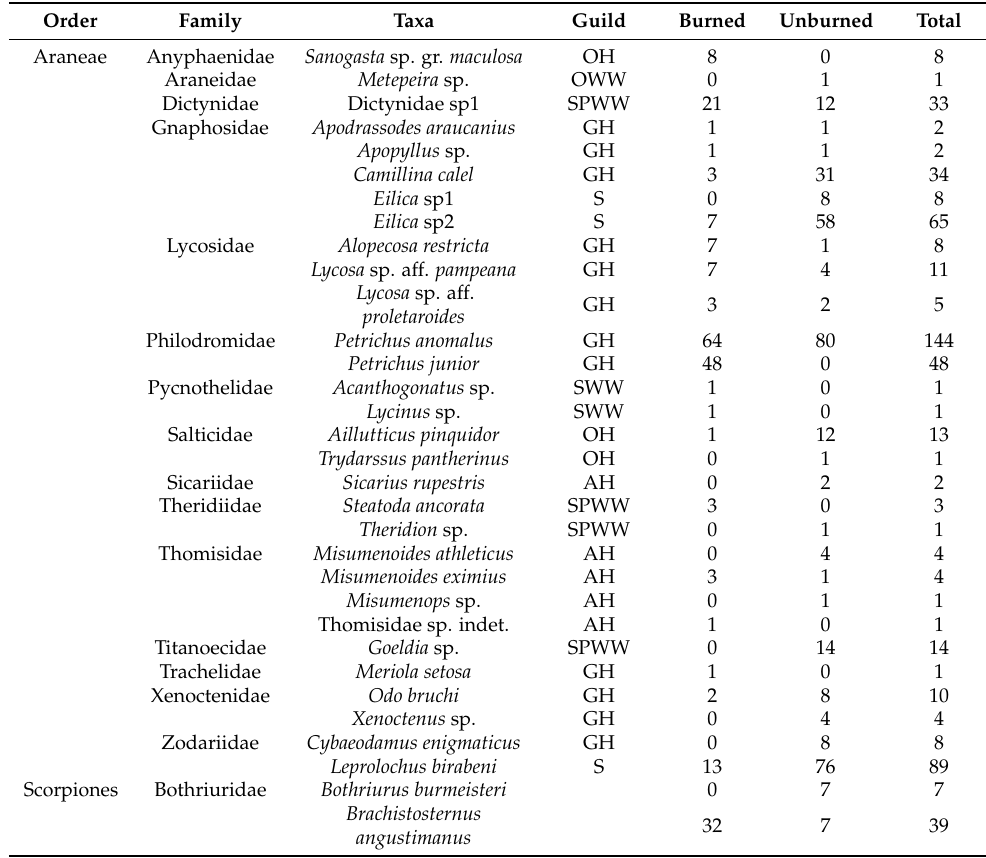
Table 1. Abundance of arachnid species/morphospecies in burned and unburned areas. The total abundance of each taxon and the assignment of spiders to each guild are also indicated. Guild abbreviations: AH = ambush hunters, GH = ground hunters, OWW = orb web weavers, OH = other hunters, SWW = sensing web weavers, SPWW = space web weavers, S =